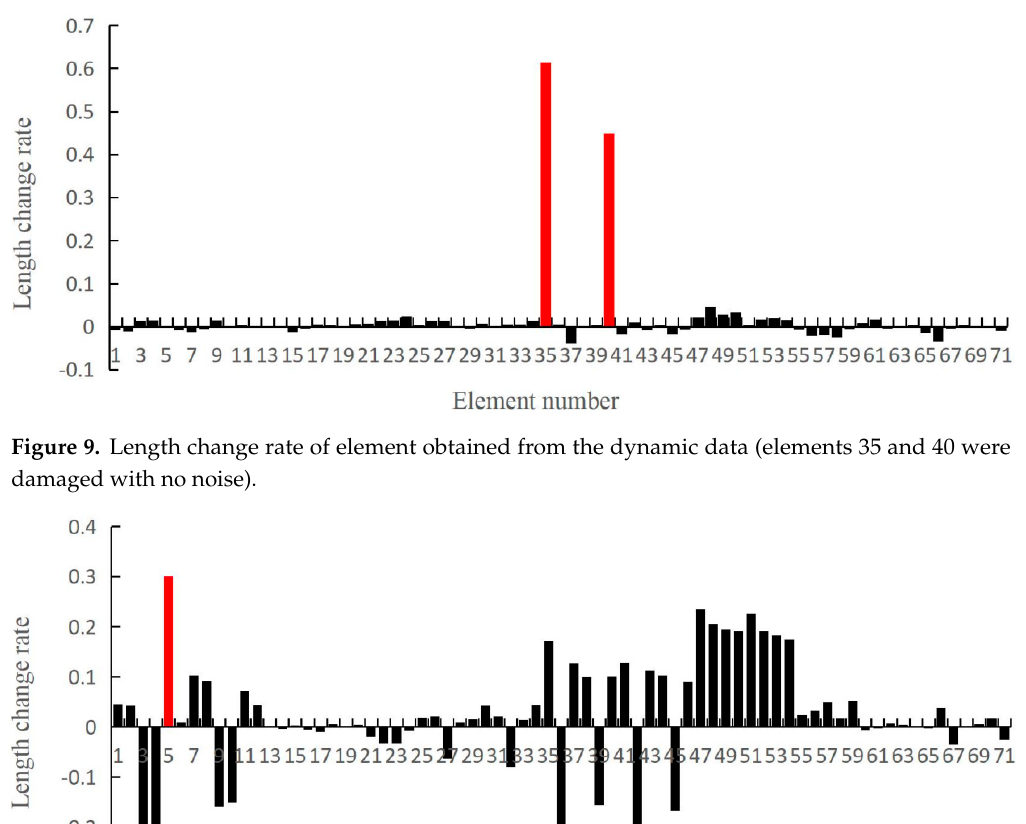
Figure 8. Length change rate of element obtained from the dynamic data (element 5 was damaged with no noise).